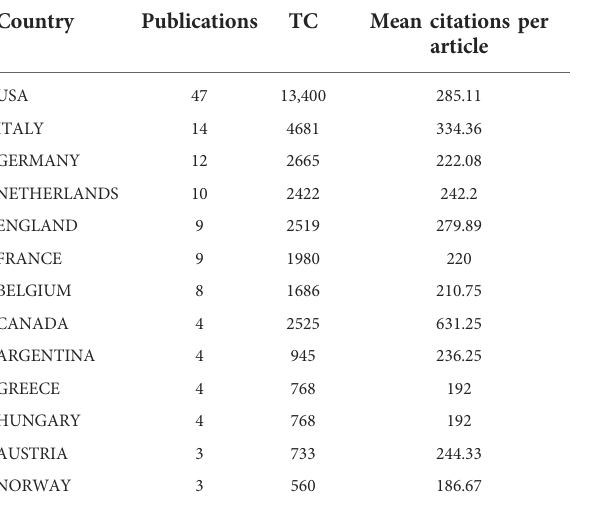
TABLE 2 Institution published at least four articles. TC=Total citations.